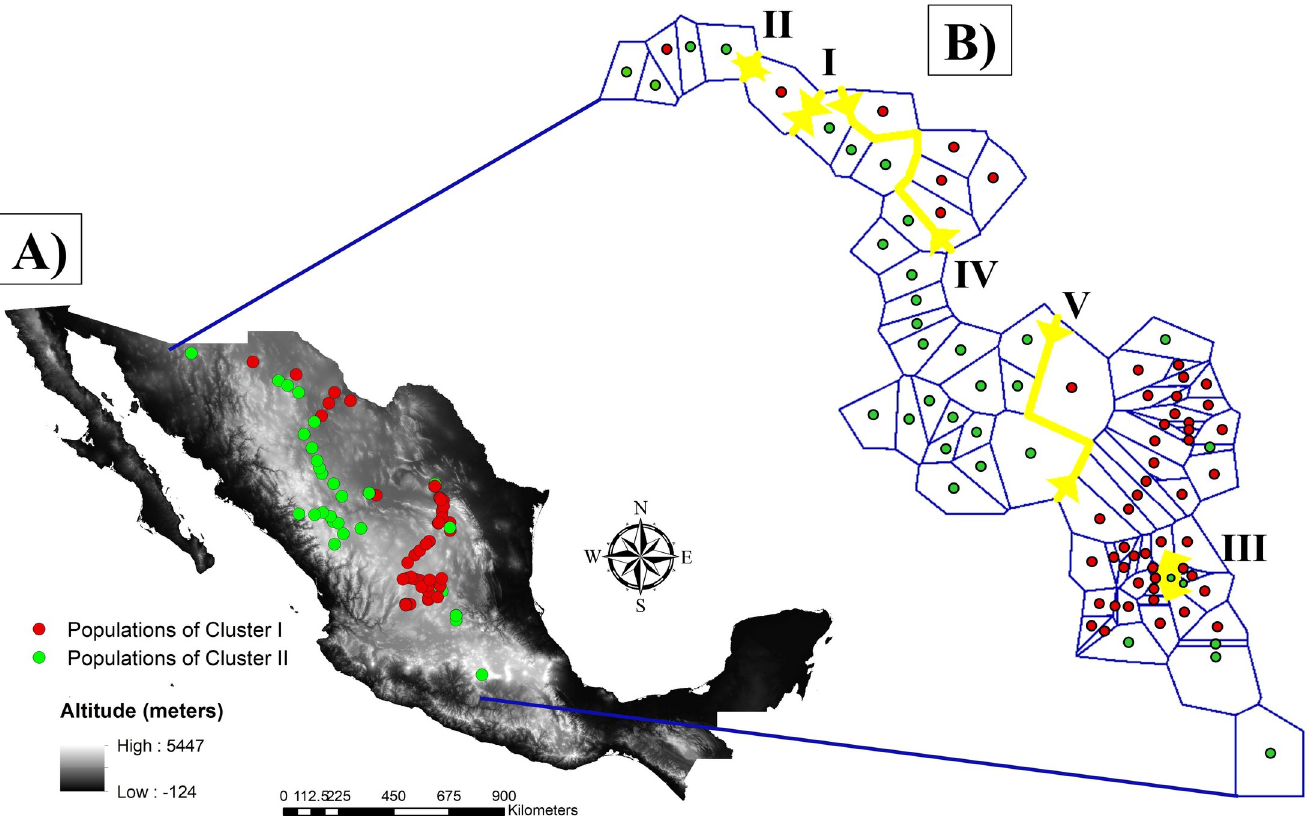
Fig 4. Genetic barriers predicted by BARRIER analysis among 85 sideoats grama ( Bouteloua curtipendula ) populations, divided into two clusters by STRUCTURE analysis. A) STRUCTURE clustering pattern in a geographical context. B) Genetic barriers (red lines) and Voronoi’s hypothetical population boundaries (blue lines). The analyses were performed base on 281 AFLP fragments. Digital Elevation Model from INEGI (https://www.inegi.org.mx). https://doi.org/10.1371/journal.pone.0254566.g004 for the LIG and present times, while Cluster II had approximately 18 thousand Km 2 more sur- face area. Table 2. Contribution (%) of 10 bioclimatic variables to the environmental niche models for two genetic clusters of sideoats grama ( Bouteloua curtipendula ), at five different intervals of time. ID